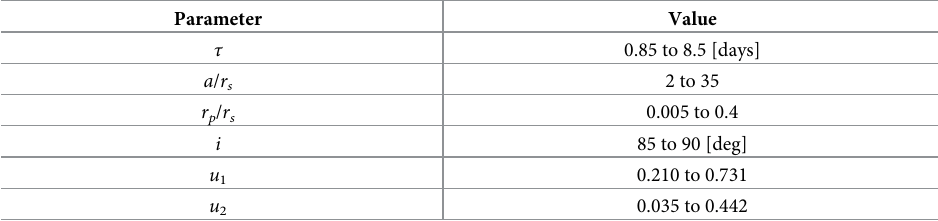
Table 2. Transit